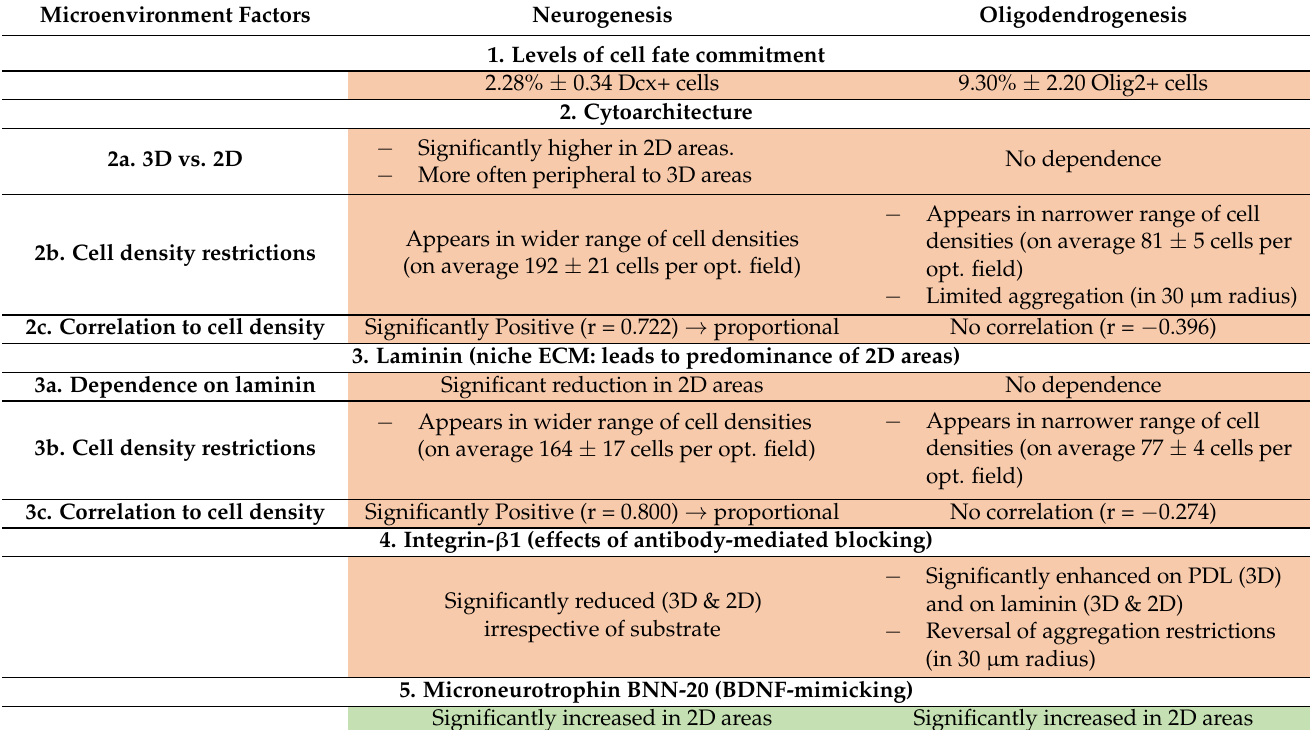
Table 1. Summary of differences and similarities between neurogenesis and oligodendrogenesis, as tested or observed in neurosphere polymorphic in vitro assays (after seven days of differentiation). Red highlights the differences and green the